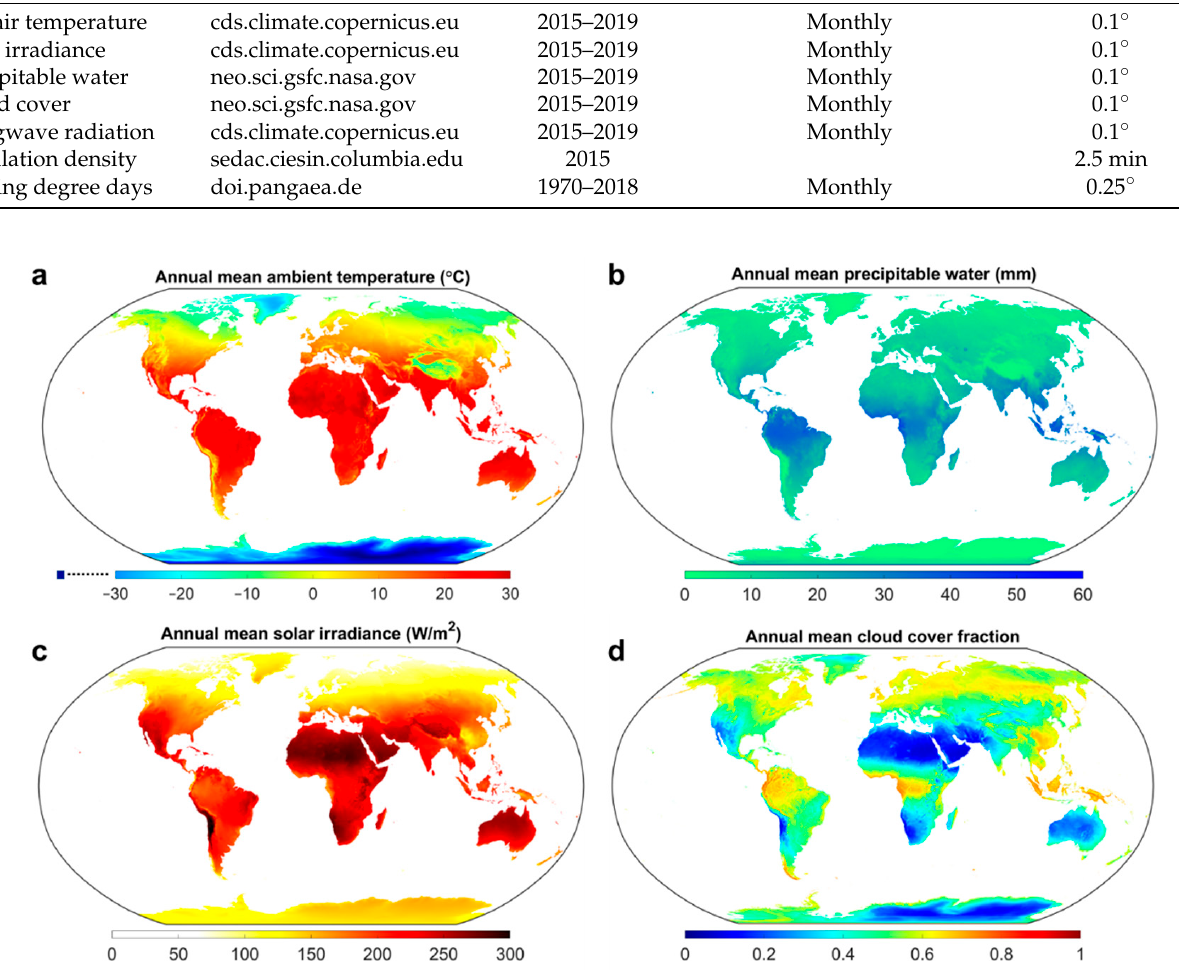
Figure 5. Global annual mean weather maps based on the monthly means of the most recent five years (2015–2019) from Refs [65,66]. ( a ) Ambient temperature, o C. ( b ) Precipitable water, mm. ( c ) Solar irradiance, W/m 2 . ( d ) Cloud cover fraction. Precipitable water refers to the thickness of the atmospheric water vapor when condensed into liquid water. Only data for land surfaces are pre-